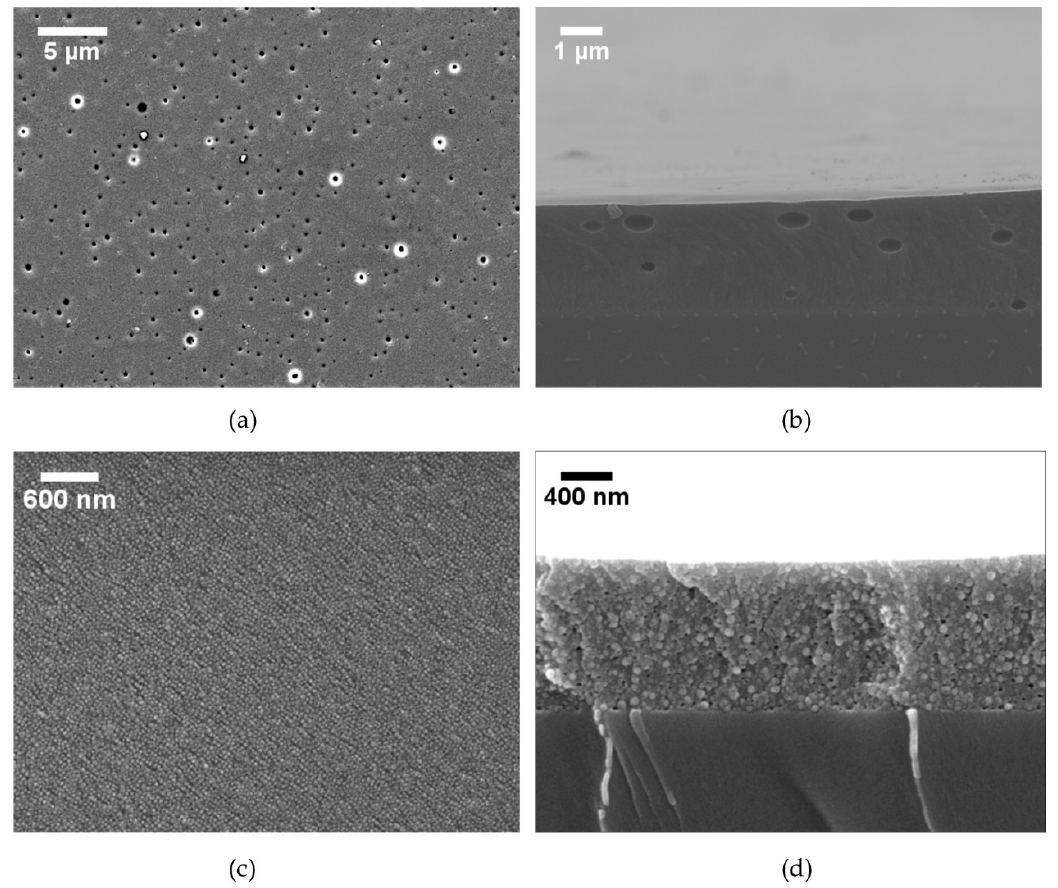
Figure 5. SEM images of as-received coupons with A in ( a ) planar view revealing surface defects and ( b ) cross-sectional view showing the presence of voids, and B in ( c ) planar view and ( d ) cross-sectional view showing no defects.